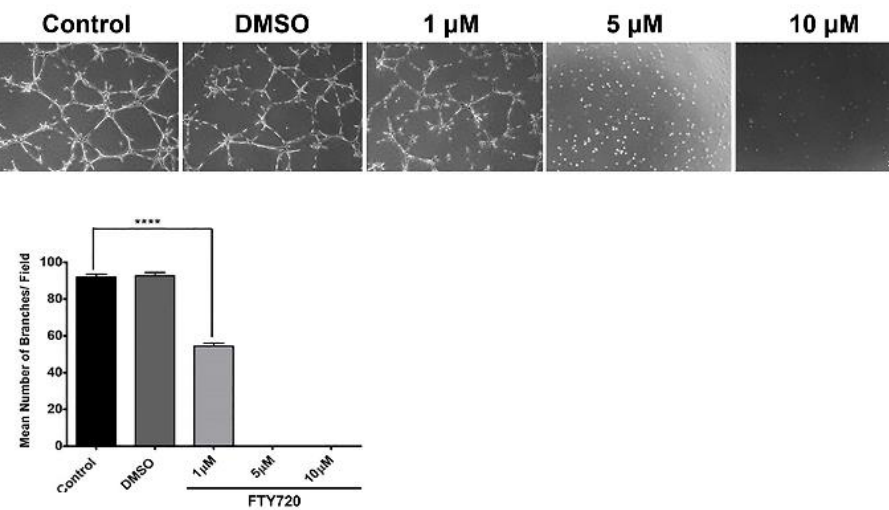
Figure 5. The S1PR agonist FTY720 inhibits ChEC capillary morphogenesis. Detached ChECs were incubated with varying concentrations of FTY720 (in DMSO) or DMSO on ice for 20 min. Incubated cells were then applied to Matrigel-coated plates, incubated, and imaged 14 h later as described in Methods. The mean number of branch points was determined as detailed in Methods. **** p < 0.0001. ( n = 3).